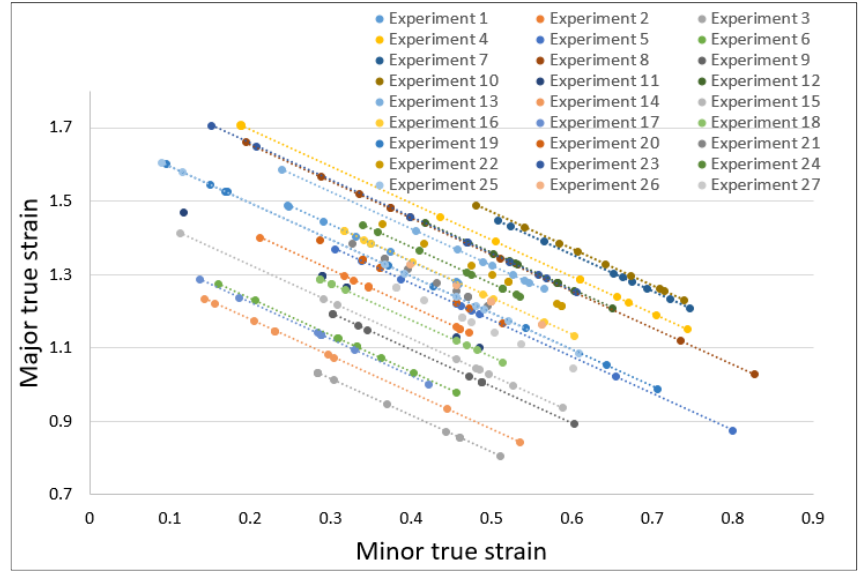
Figure 5. Strain-based FFLD for AZ31 Mg alloy.